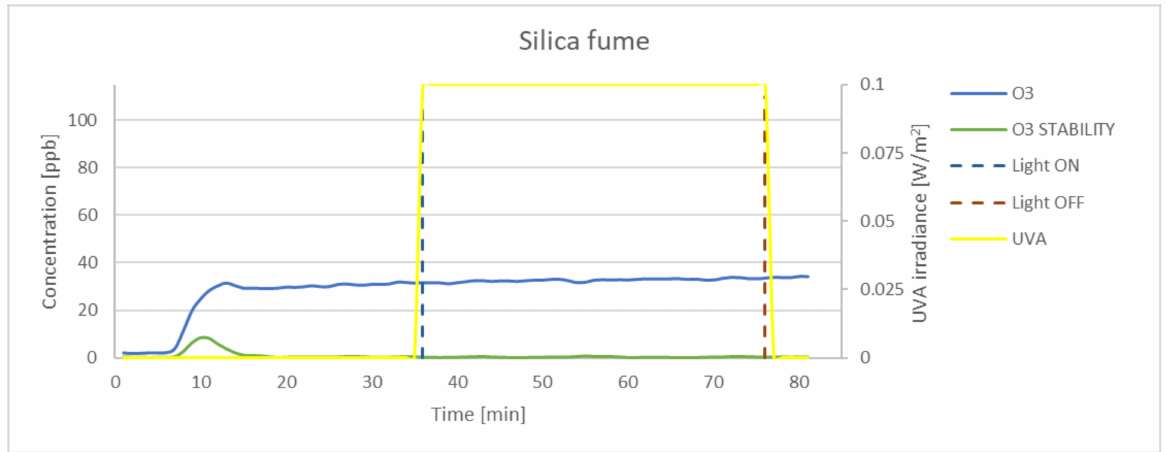
Figure 12. The oxidation of O 3 in the photocatalytic reaction with concentrations measured for silica fume. Data on UVA irradiation are shown in the supplementary chart. Dashed lines indicate the time of light on and off.